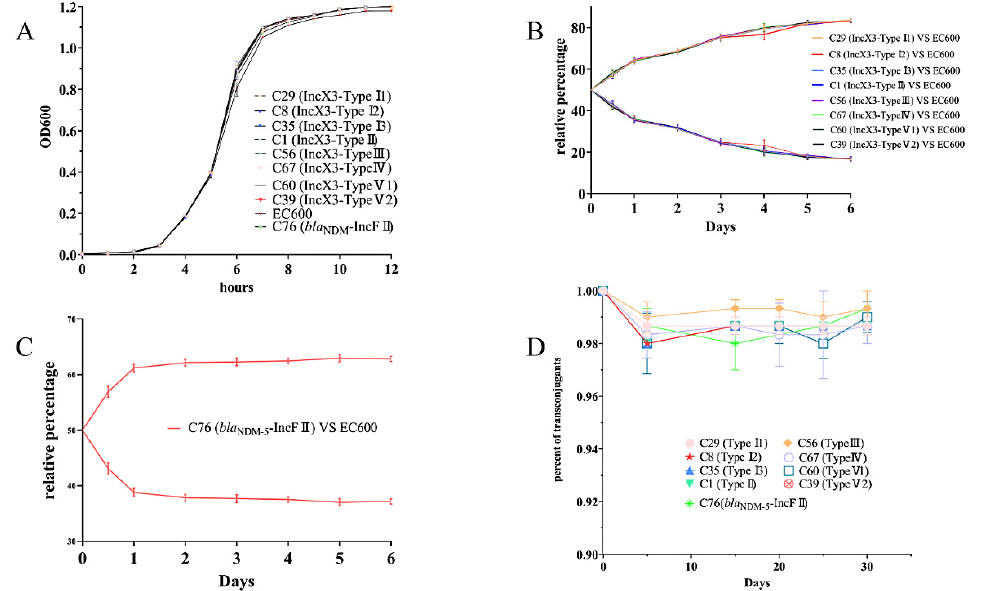
Figure 7. Adaptability and stability of bla NDM -positive plasmid. ( A ) Growth curve of 9 kinds of transconjugant. ( B ) Competitive growth results obtained for bla NDM -IncX3 transconjugants and recipient bacteria EC600. ( C ) Competitive growth results obtained for carrying bla NDM-5 -IncF Ⅱ transconjugants and recipient bacteria EC600. ( D ) Results obtained for continuous passage of bla NDM -IncX3 and bla NDM -IncF Ⅱ -carrying plasmid transconjugants.